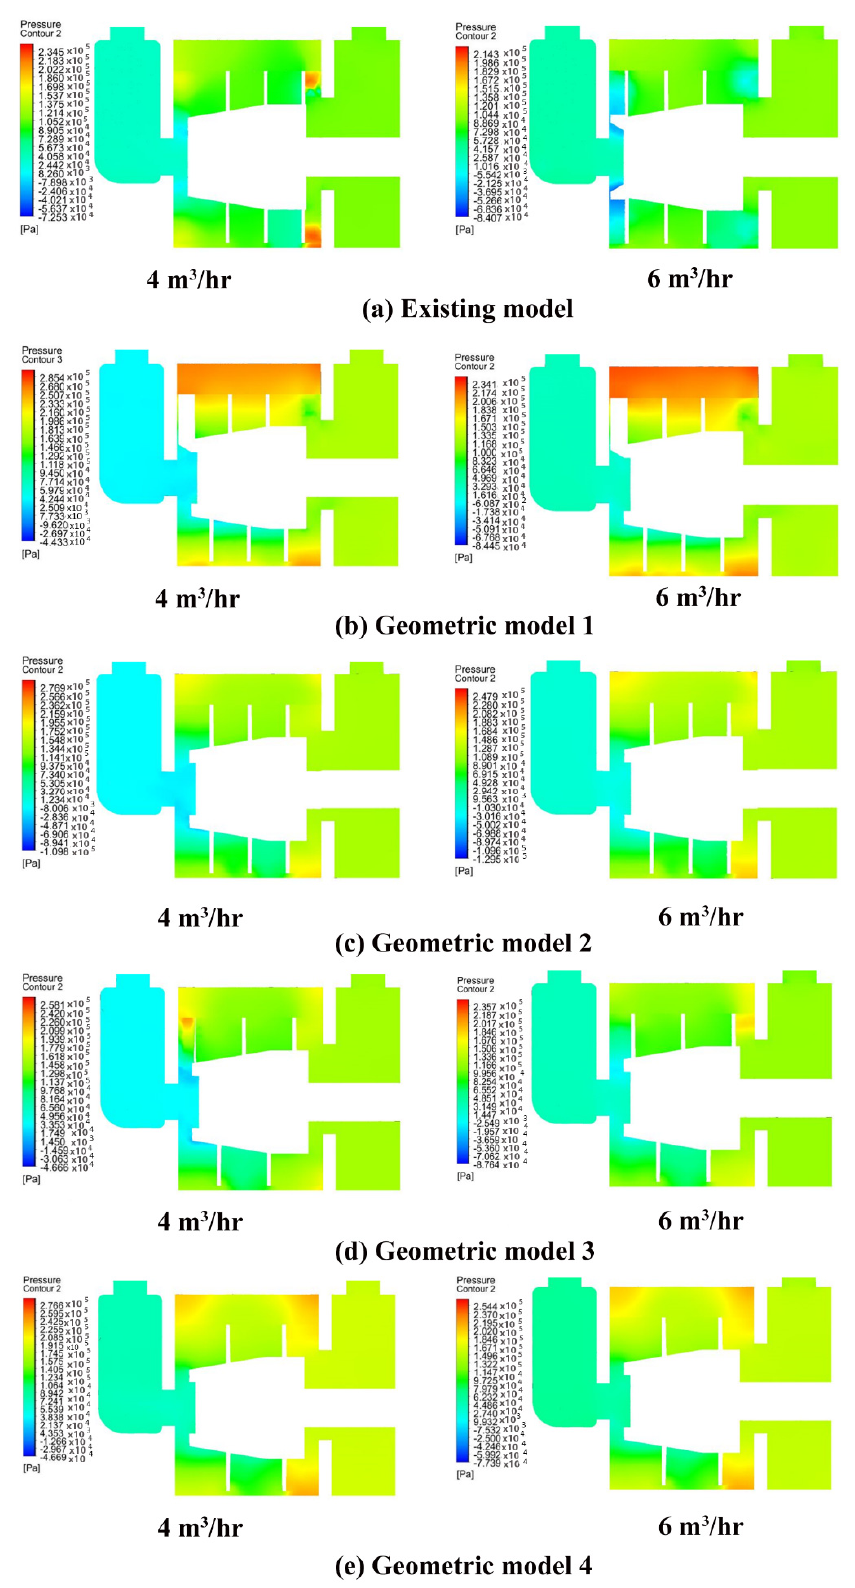
Figure 17. Variation of static pressure in different geometric models ( a ) Existing model ( b ) Geometric model 1 ( c ) Geometric model 2 ( d ) Geometric model 3 and ( e ) Geometric model 4.